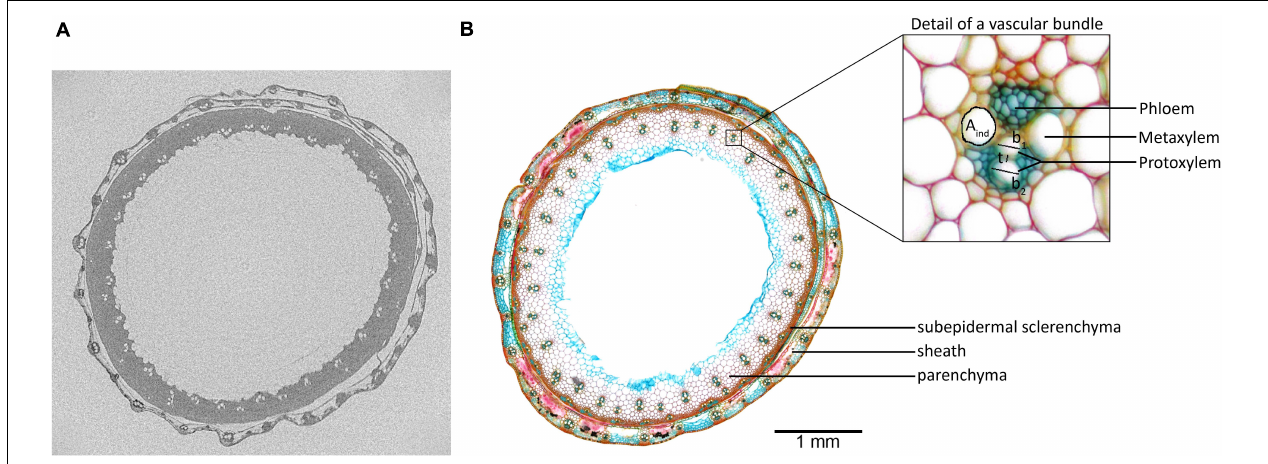
FIGURE 2 | (A) Reconstruction of the EMCT image of Excalibur, taken 26 h after onset of dehydration. From this exact scanning position, (B) a 70- µ m-thick cross-section was made and stained with 0.5% (w/v) astra blue, 0.5% (w/v) chrysoidine, and 0.5% (w/v) acridine red. Individual vessel area (Aind), wall span (b), and wall thickness (t) are indicated on the detailed magnification of the vascular